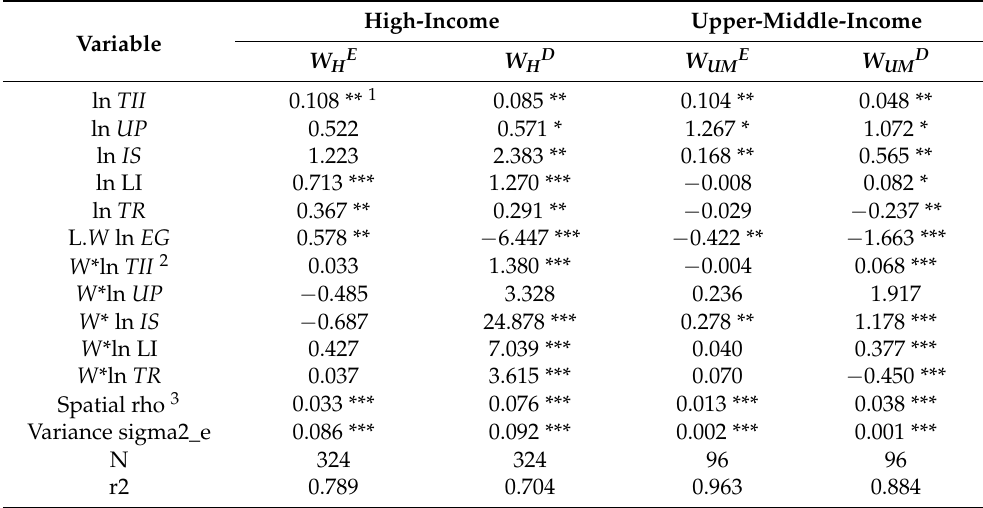
Table 7. Regression results of the SDM for OECD+ countries with different income levels.